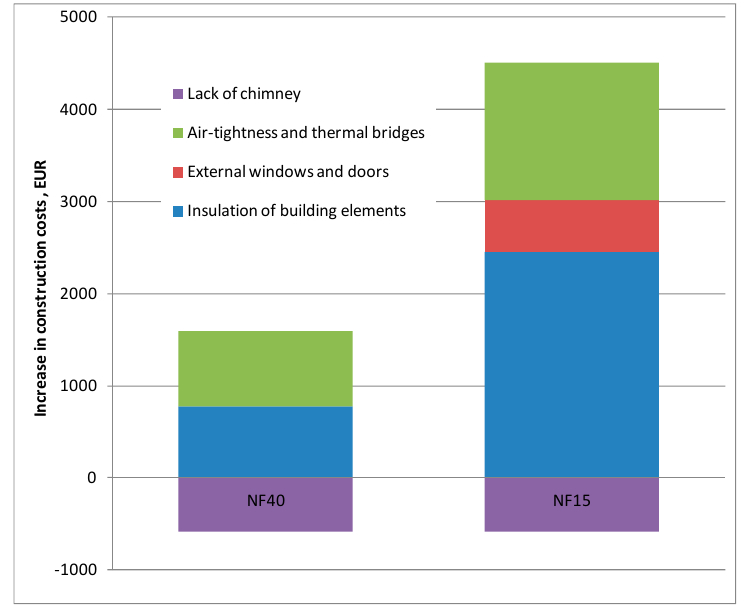
Figure 3. The increase in construction costs for the standards NF40 and NF15.